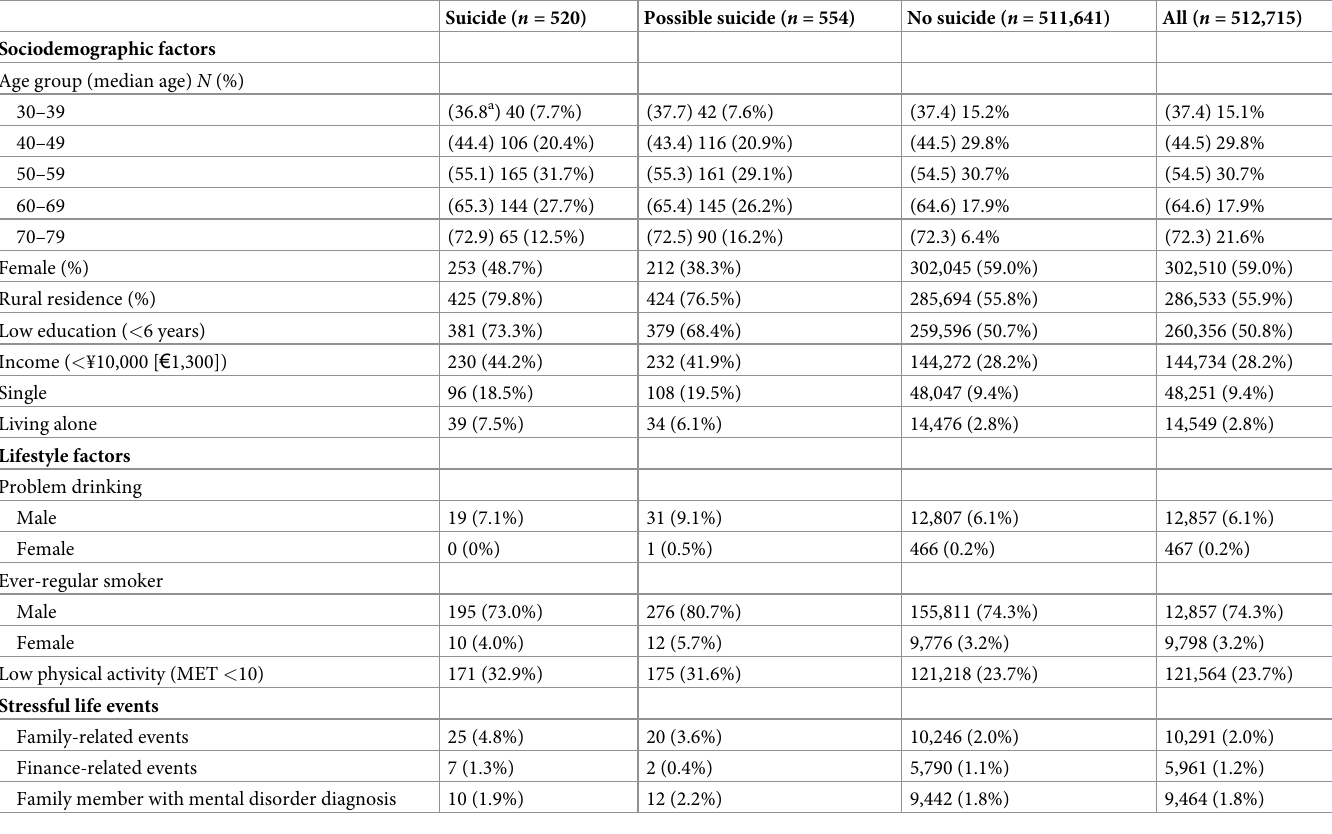
Table 1. Demographic and lifestyle characteristics and stressful life events of participants by suicide status during follow-up.